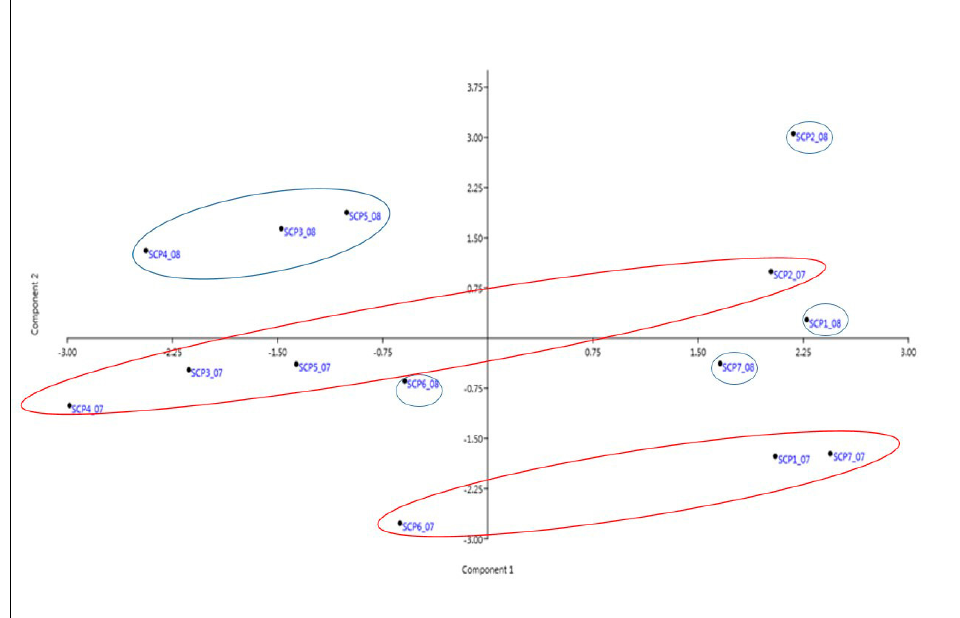
Figure 5. Distribution of the accessions on the score plot for the two principal components. In the graph, the dots refer to accessions of Capparis spinosa subsp. rupestris grown in the first year while the squares refer to accessions grown in the second year, the same color refers to the same accession.